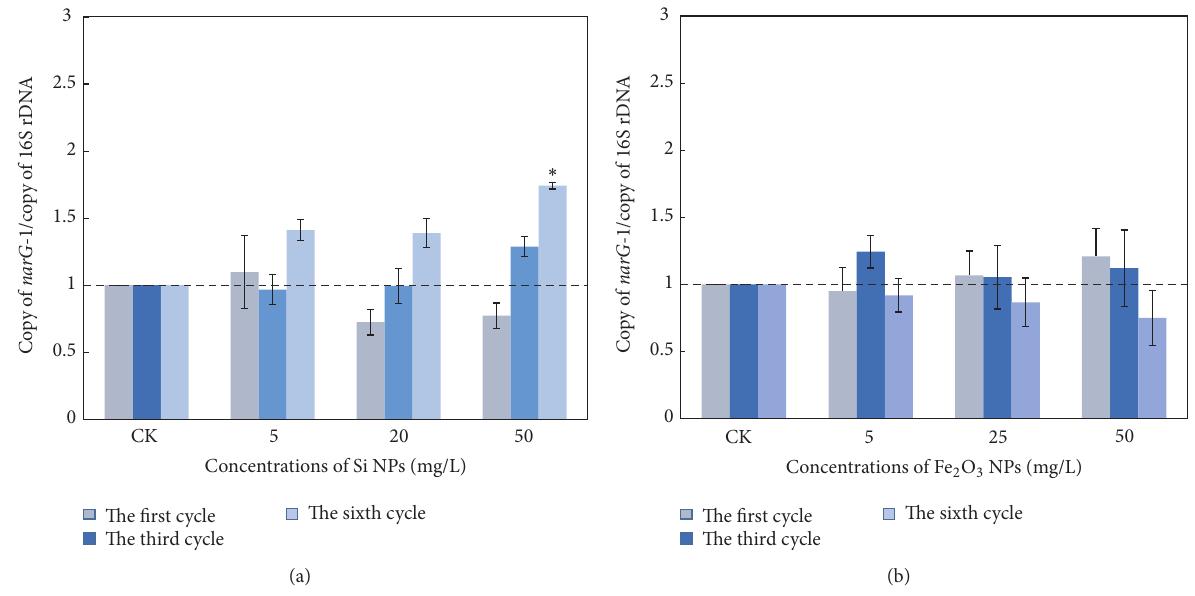
Figure 7: Quantitation of narG -1 transcript levels in reactors. We used RT-PCR to determine the amount of target gene narG -1 in the reactors with different concentrations of Si NPs (a). Similarly we measured the amount of target gene narG -1 in the reactors with different concentrations of Fe 2 O 3 NPs (b). The error bars represent standard deviations from the mean. Asterisks indicate a statistical difference ( 𝑝 = 0.05 ) between that treatment and the control group.